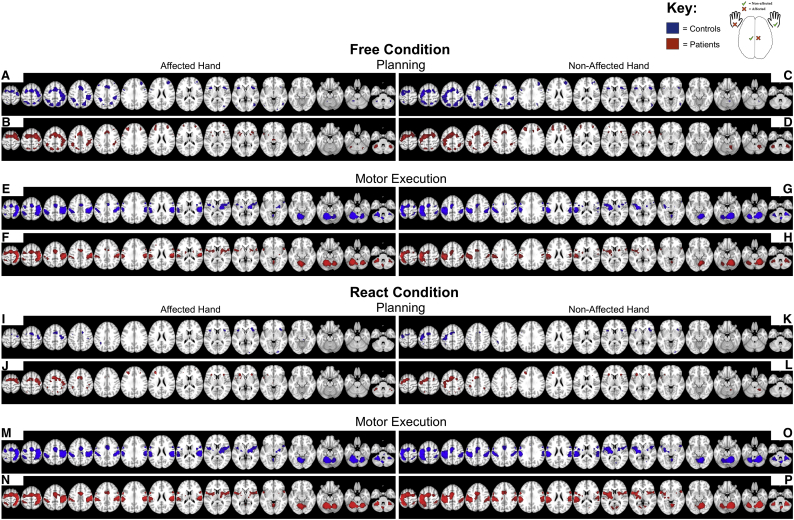
Within-group analysis.Within-group activations for the preparation and execution of action, compared to REST, in healthy control participants (Blue: A, C, E, G, I, K, M, O) and de novo Parkinson's Disease patients (Red: B, D, F, H, J, L, N, P). Activation for the preparation and motor execution of self-initiated action are shown in the top half of the figure (FREEPLAN and FREEMOTOR, respectively). Activation for the preparation and motor execution of externally cued action are presented in the figure's lower half (REACTPLAN and REACTMOTOR, respectively). Shown is the significant within-group signal increases (p < .05, FWE corrected at voxel-level) represented on an MNI-T1-template brain, displayed using multiple axial transections. Coordinates shown (z only) are in MNI-space. (For interpretation of the references to color in this figure legend, the reader is referred to the web version of this article.)